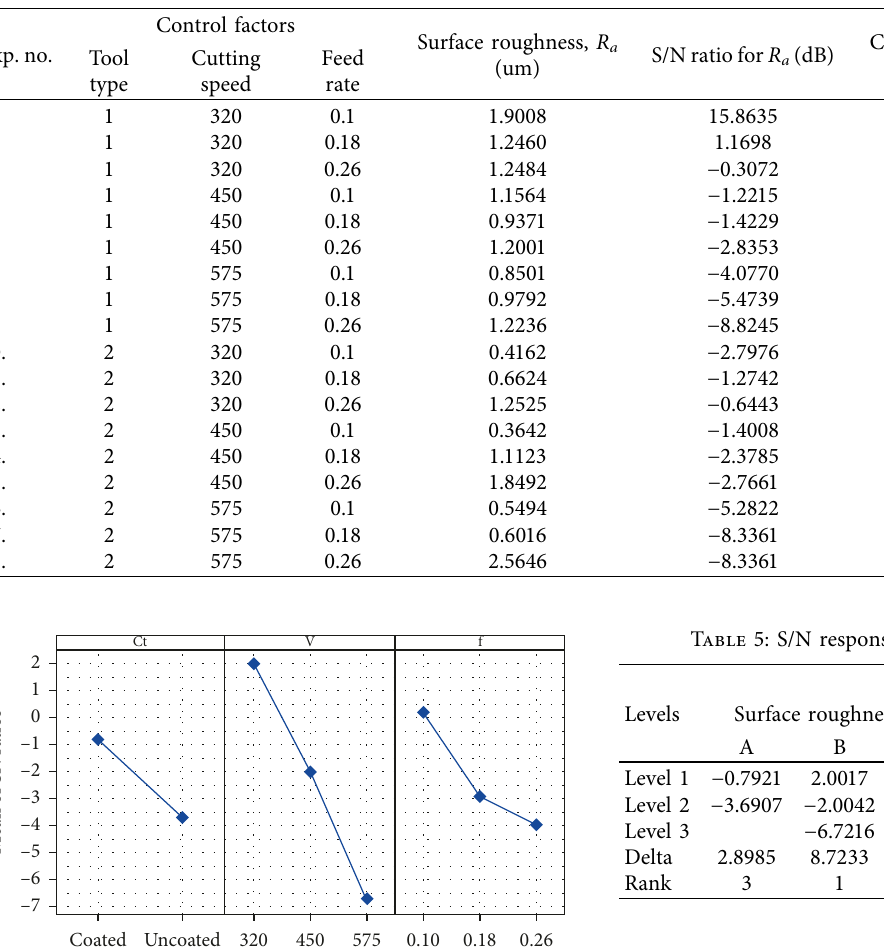
Figure 3: Effect of process parameters on average S/N ratio for R